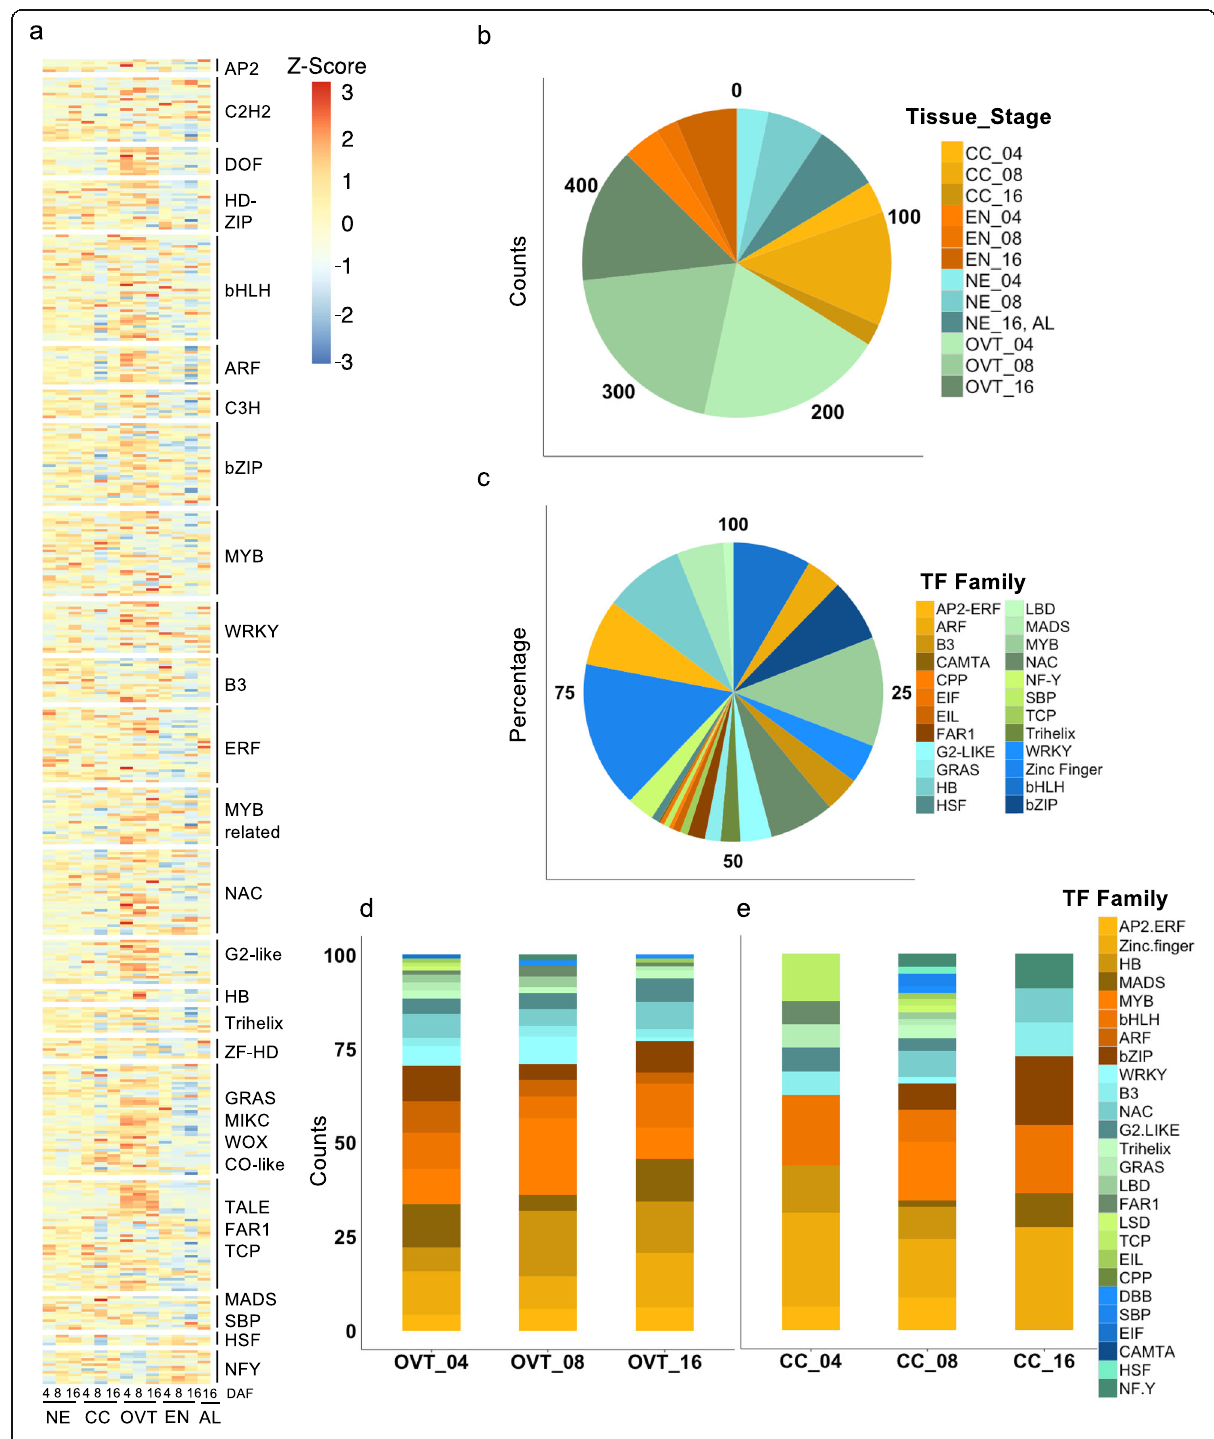
Fig. 4 Analysis of DEGs encoding transcription factors (TFs). a Overview of heatmap for all differentially expressed TF encoding genes. b Percentage of differentially expressed TF-encoding genes in different sub-regions and at different growth stages of the developing rice grains. c Distribution of TF families among the differentially expressed TF encoding genes in the data set. d Distribution of TF families in the OVT and CC (e) tissues at different stages of the developing rice